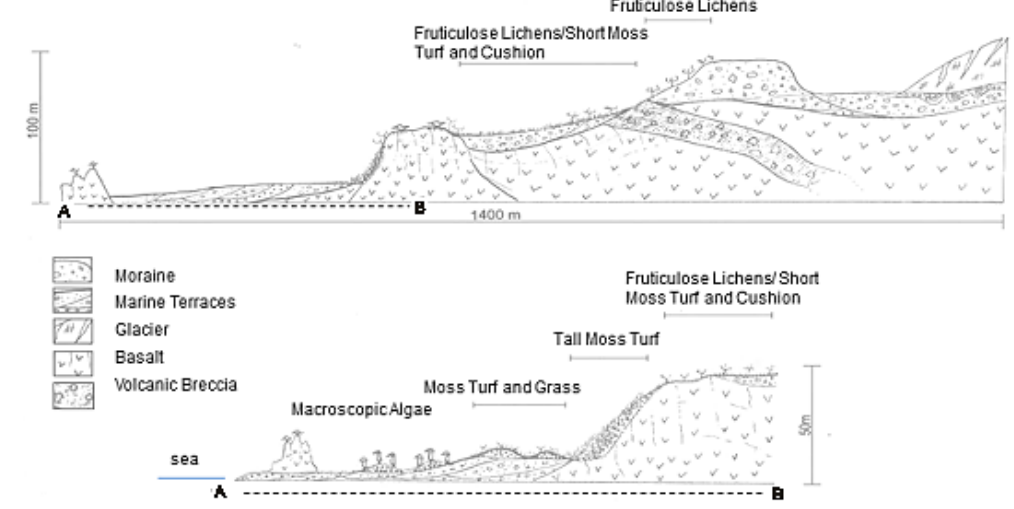
Figure 4. Topographic sequence and distribution of vegetation at Stranger Point, Potter Peninsula.